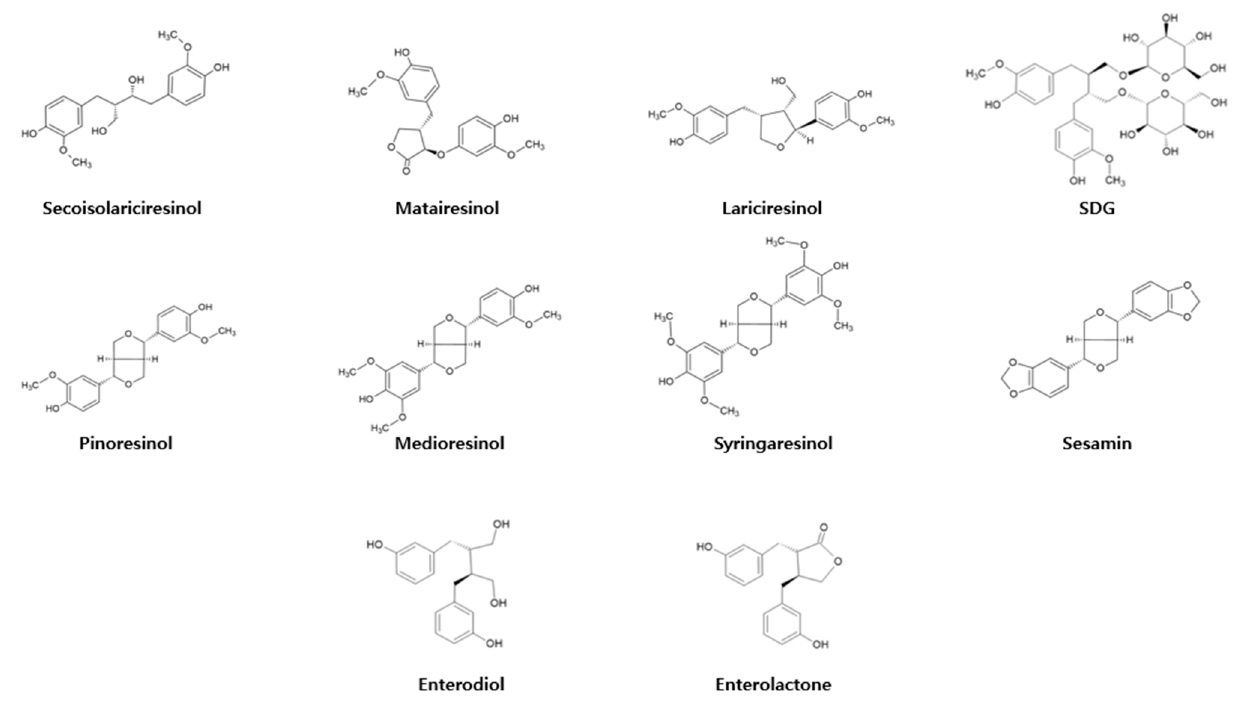
Figure 1. Chemical structures of lignans and their metabolites (END and ENL).